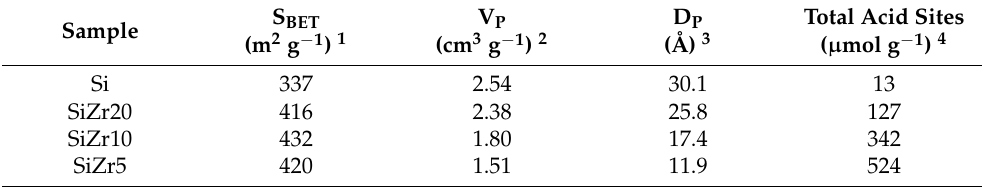
Table 1. Textural properties of the porous silicas and total acid sites estimated from NH 3 -TPD.